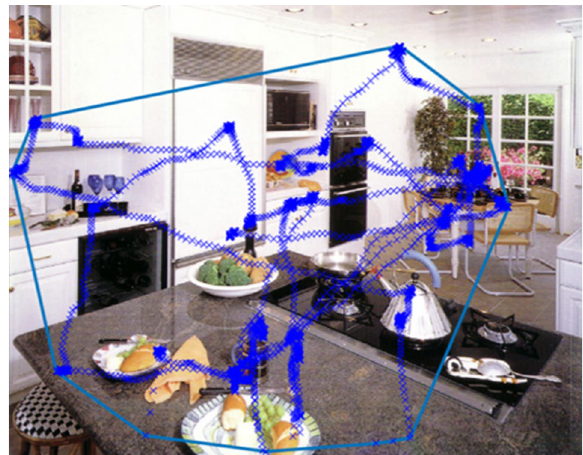
Figure 9. Percentage of image viewed analysis. Example of a subject’s raw gaze-data (blue x’s), overlaid with the convhull() polygon (teal lines). Area of the polygon is divided by the area of the image (not including gray stimulus background), to produce an approximate estimate of the percentage of the image viewed by the subject. Image is from the LabelMe Database 45 , made publicly available to the research community without